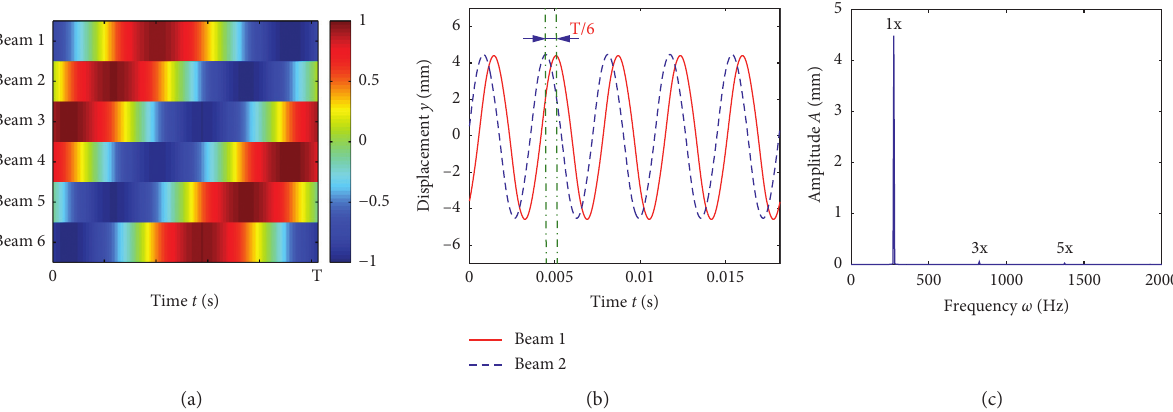
Figure 6: The response of beam tip for Ω = 200 rad/s: (a) response of beam 1 to beam 6, (b) response curve of beam 1 and 2, and (c) spectrum plot of beam 1.